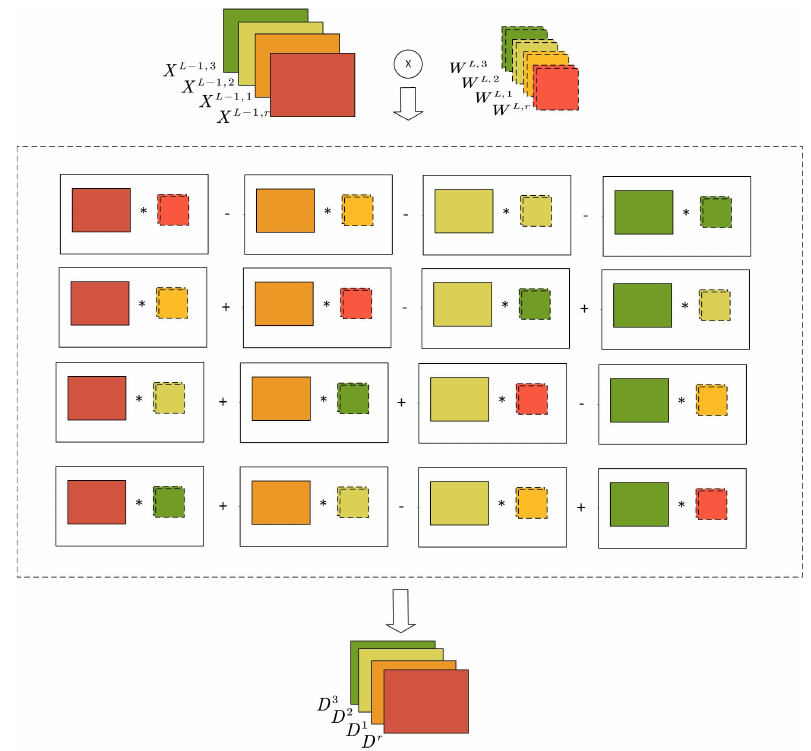
Figure 4. The implementation of geometric algebra convolutional